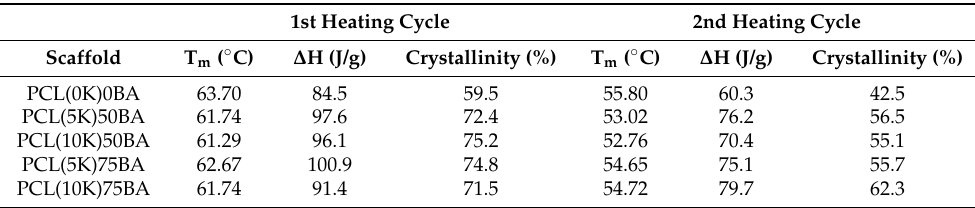
Table A1. Thermal properties of PCL-based scaffolds under sc-foaming conditions followed by thermal porogen